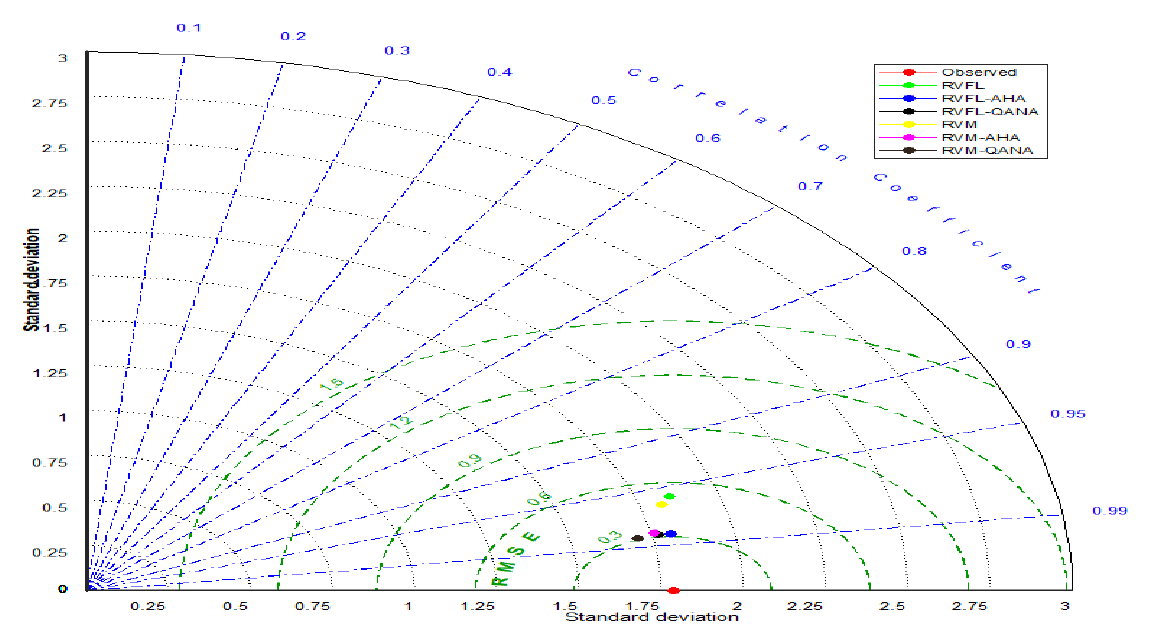
Figure 10. Taylor diagrams the predicted ET by different RVFL ‐ and RVM ‐ based models in the test period using the best input combination –Station 2 (Peshawar).